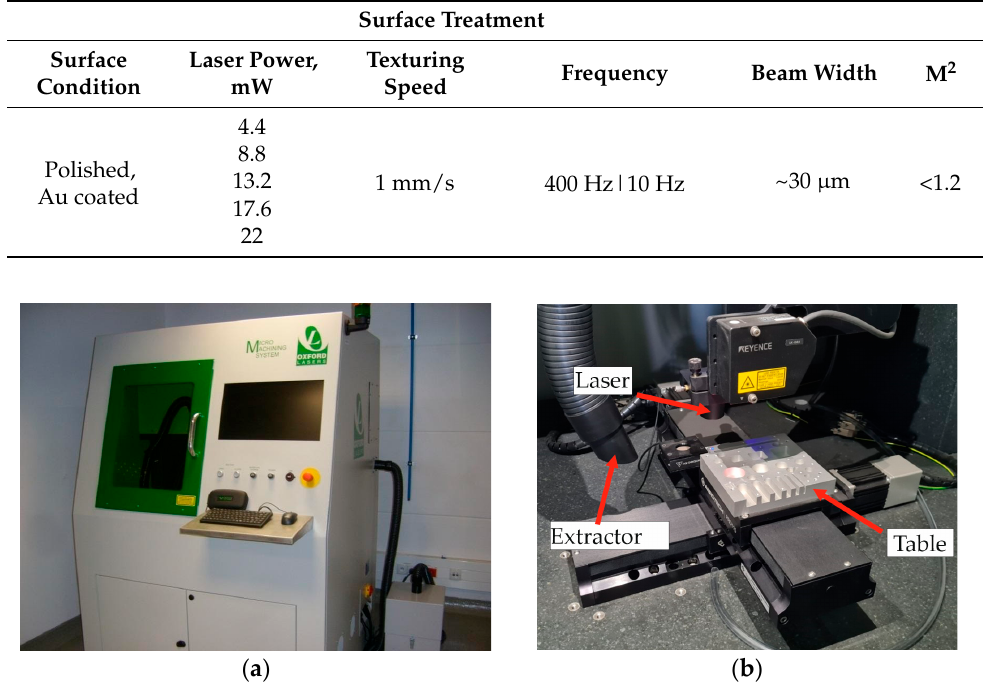
Figure 3. Oxford laser micromachining system: ( a ) housing/radiation shield, ( b ) laser head, table, and fume extractor.